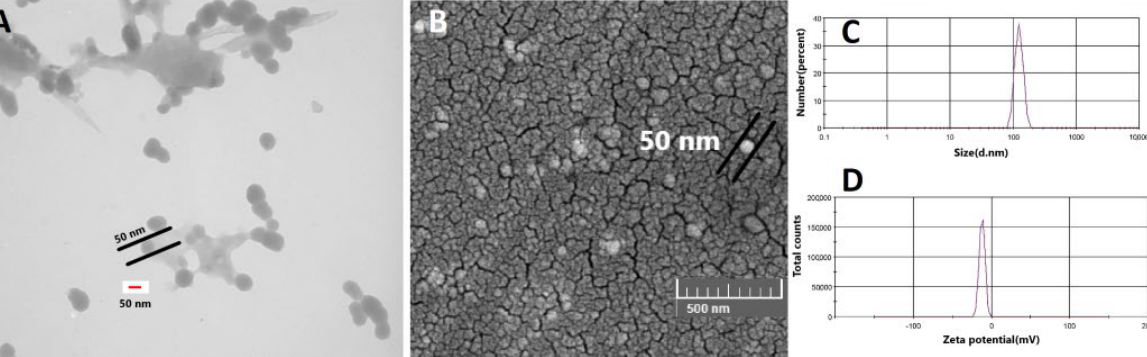
Figure 2. TEM ( A ) and SEM ( B ) photographs of iodine nanoparticles coated with amino-PEG (INP1). ( C ) Size distribution of iodine nanoparticles, ( D ) Zeta potential distribution of iodine nanoparticles.